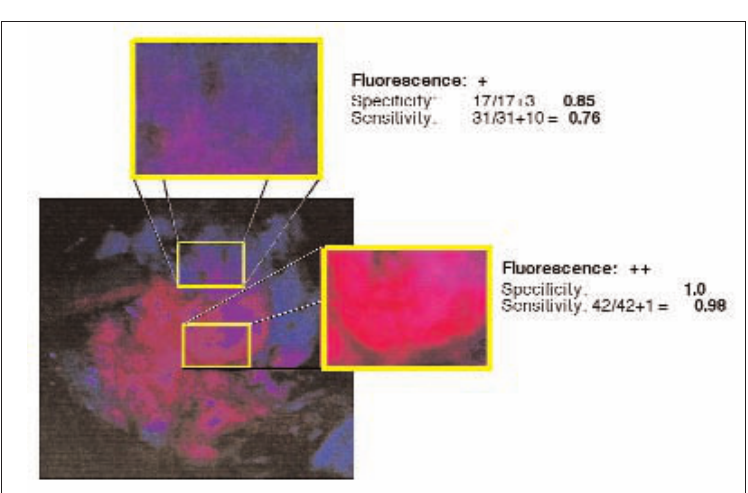
Intraoperative mi- croscopic image of a glioblastoma multi- forme as seen under 440 nm UV light (tu- mour is red fluores- cence). Enlarged are shown tumour regi- ons with “solid” (++) and “vague” (+) fluo- rescence; sensitivity and specificity for PIX fluorescence are strongly influenced by the intensity of the